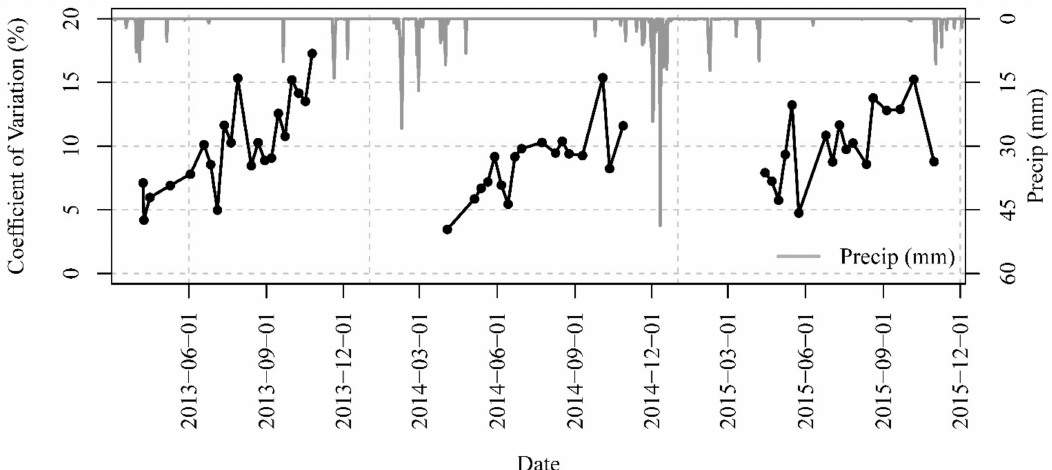
Figure 9. Coefficient of variation of mean ET calibrated by four sets of calibration pixels ( Min Min , Max Max , Min Max , and Max Min ). Precipitation added to the plot shows that antecedent moisture conditions did not affect the variability.